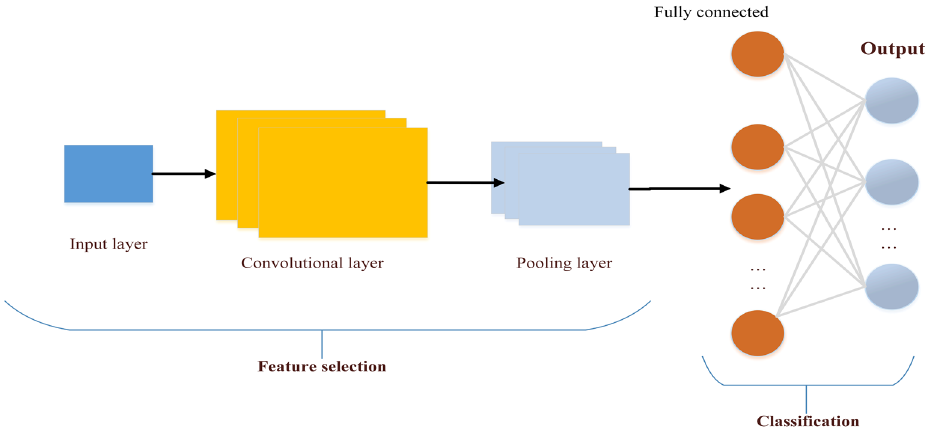
Figure 10. CNN architecture.